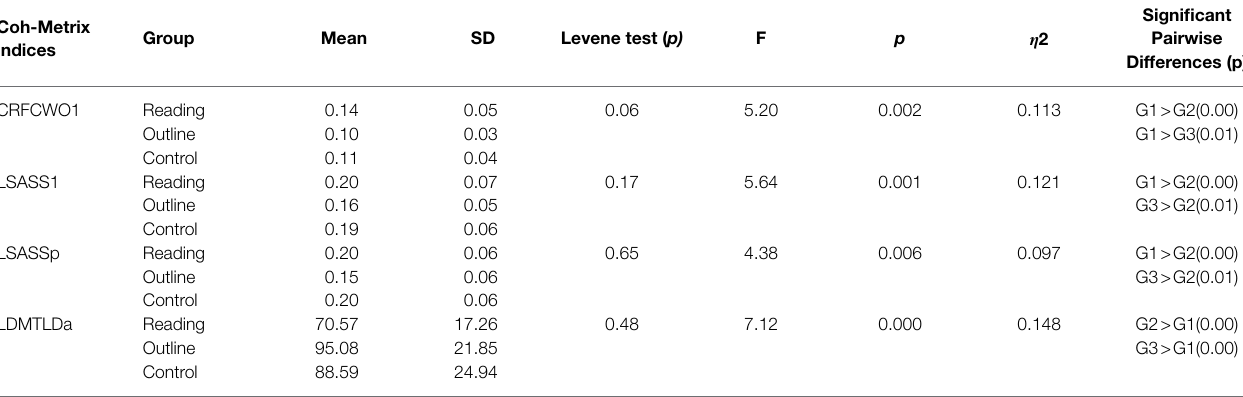
TABLE 4 | Results for significant differences between groups at